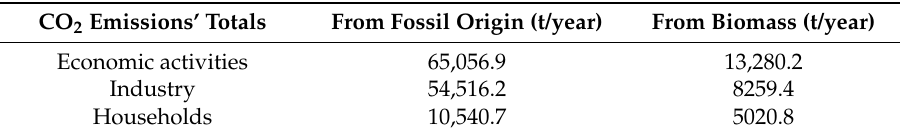
Table 2. CO 2 emissions’ totals data.